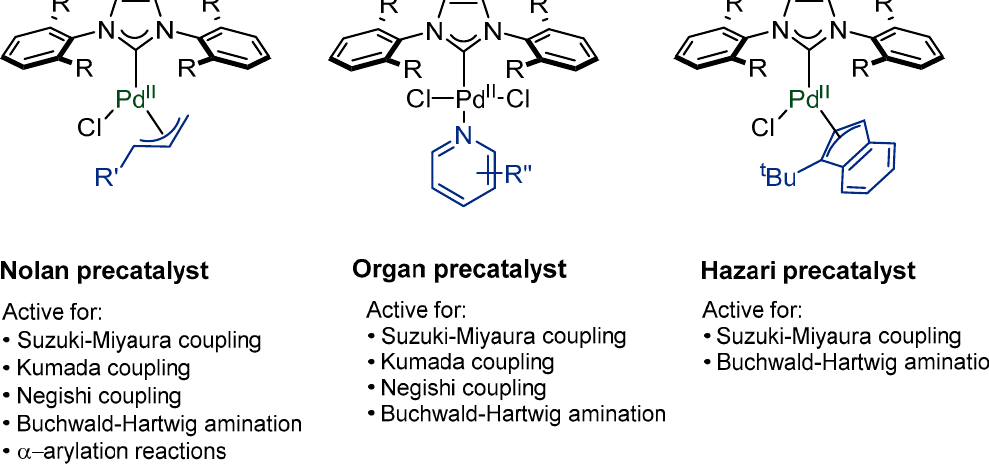
Figure 1. Overview of cross-coupling reactions catalyzed by Pd(II)-NHC pre-catalysts.